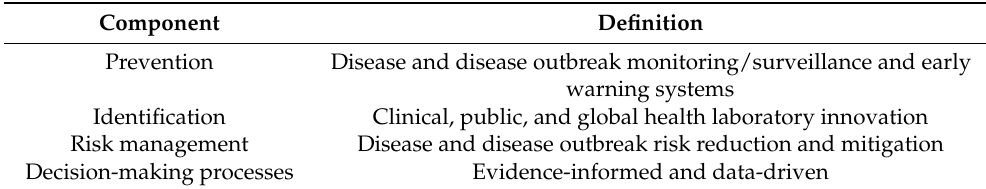
Table 1. The four major components of clinical medicine, and public and global